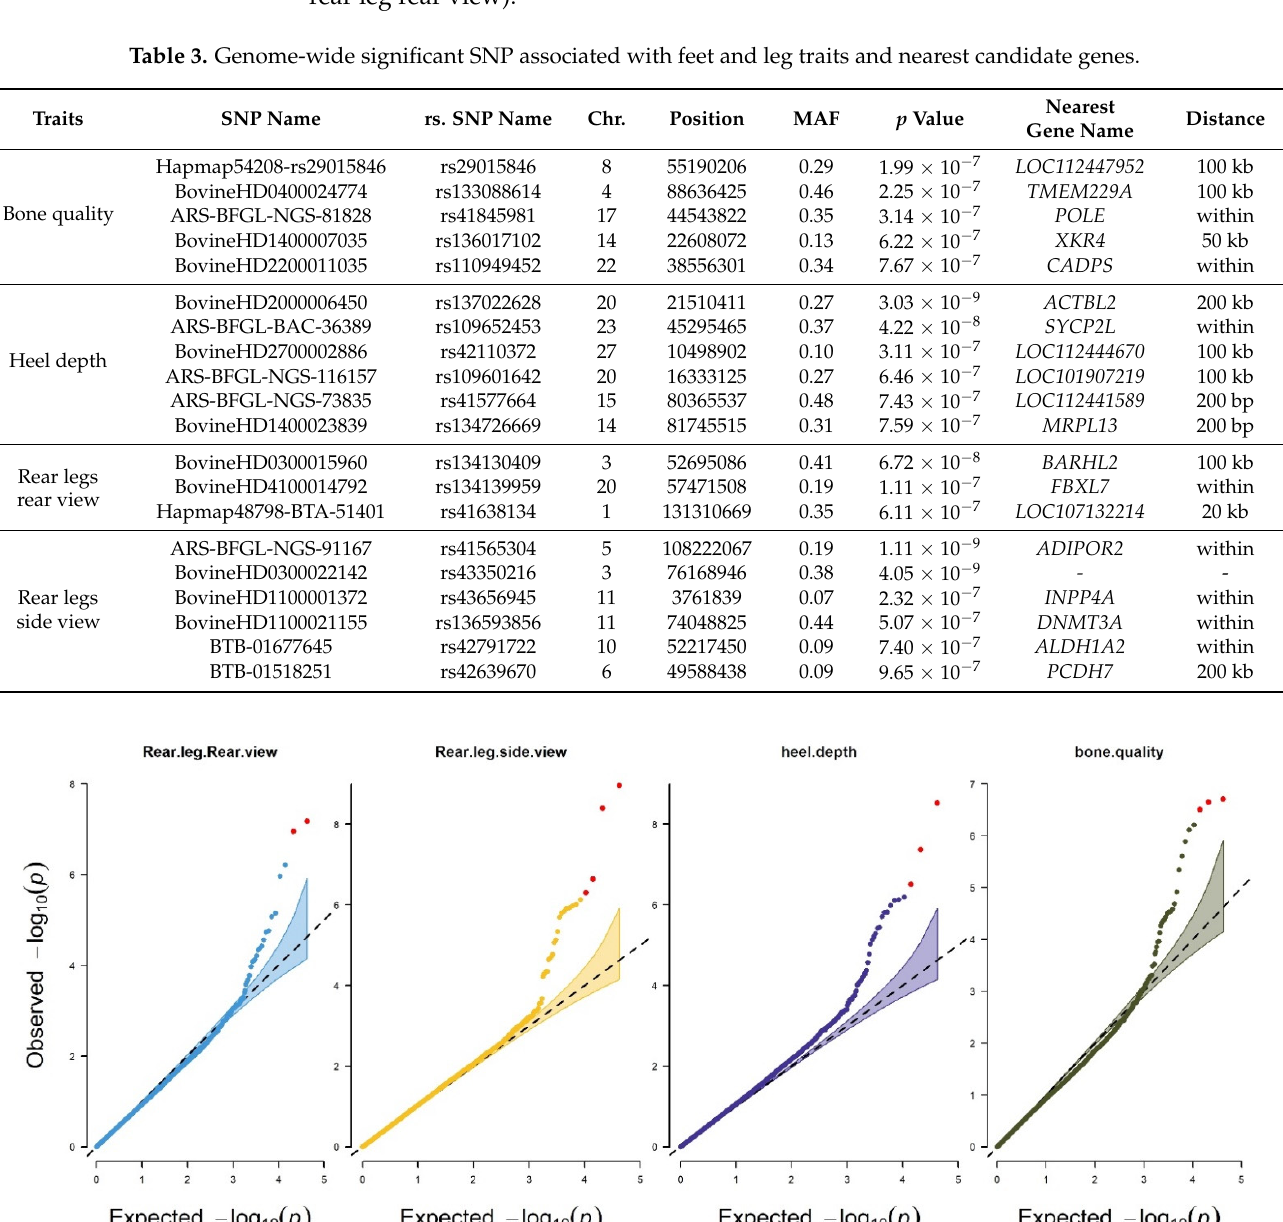
Table 3. Genome-wide significant SNP associated with feet and leg traits and nearest candidate genes. Traits